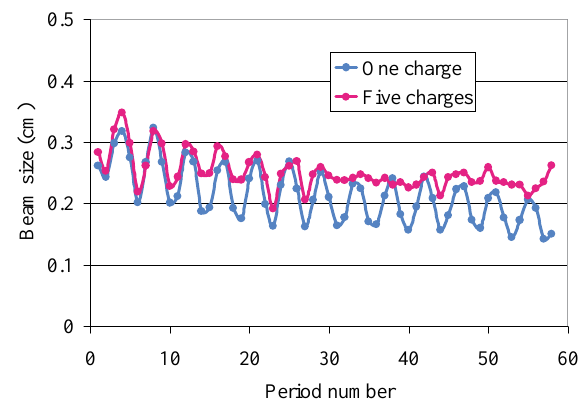
FIG. 10. (Color) Transverse beam envelopes for one charge state beam (blue dots) and five charge state beam (magenta dots). Input beam is mismatched by a factor of 1.4.